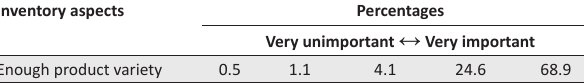
TABLE 7: Respondents’ importance rating of holding a variety of inventory.